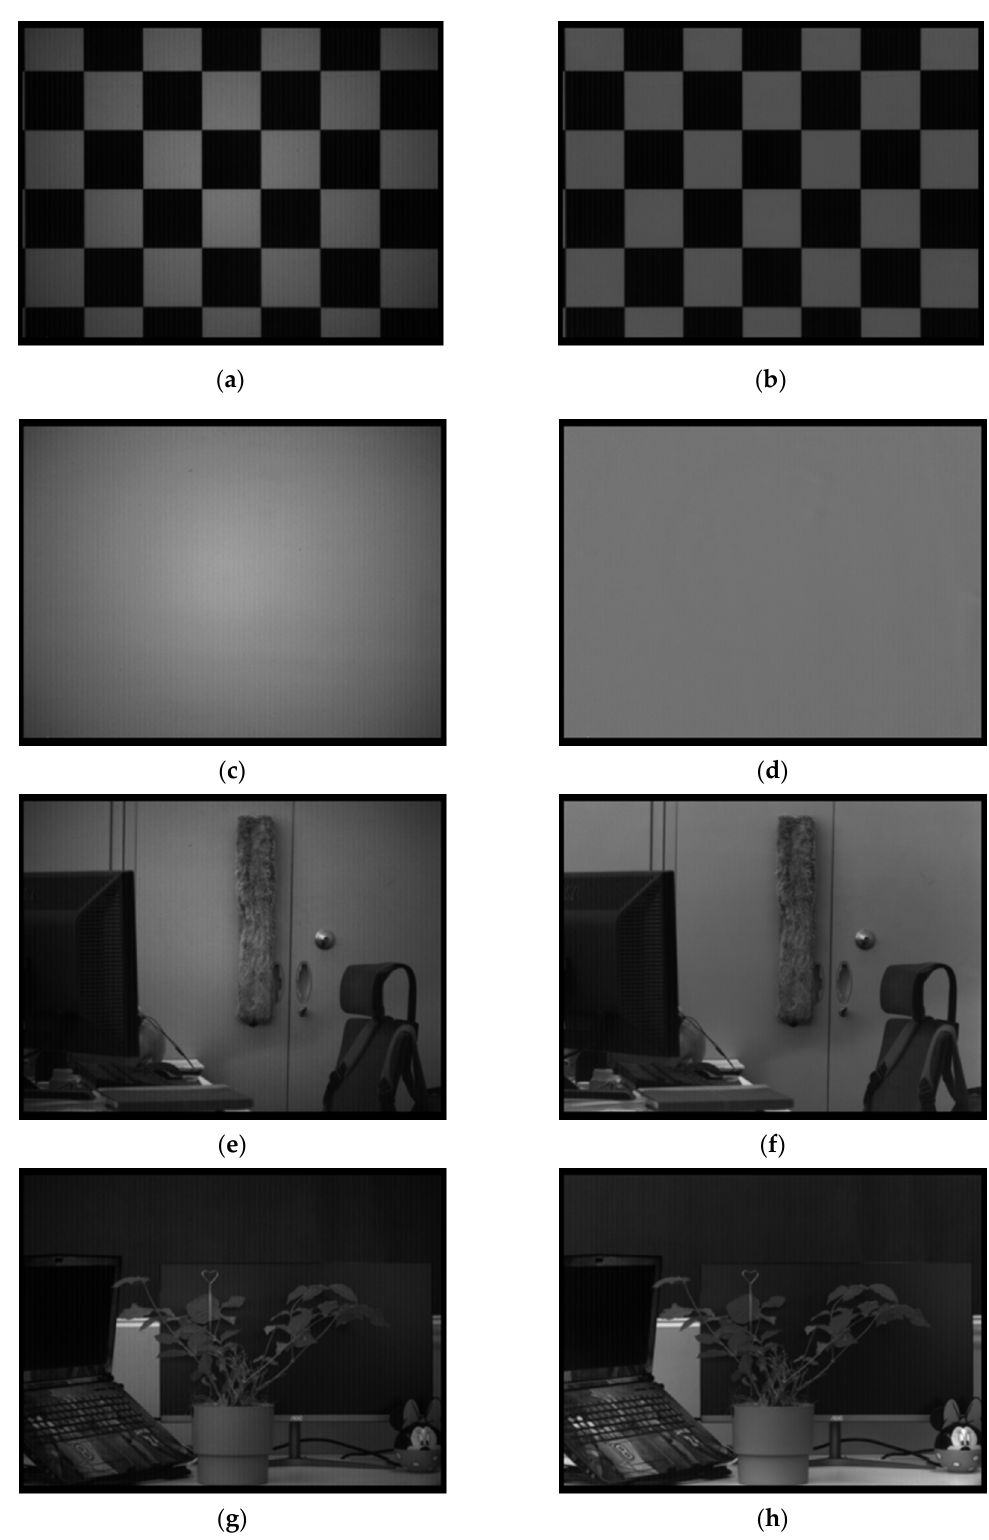
Figure 11. Results of grayscale image calibration. Images ( a , c , e , g ) are captured before calibration,